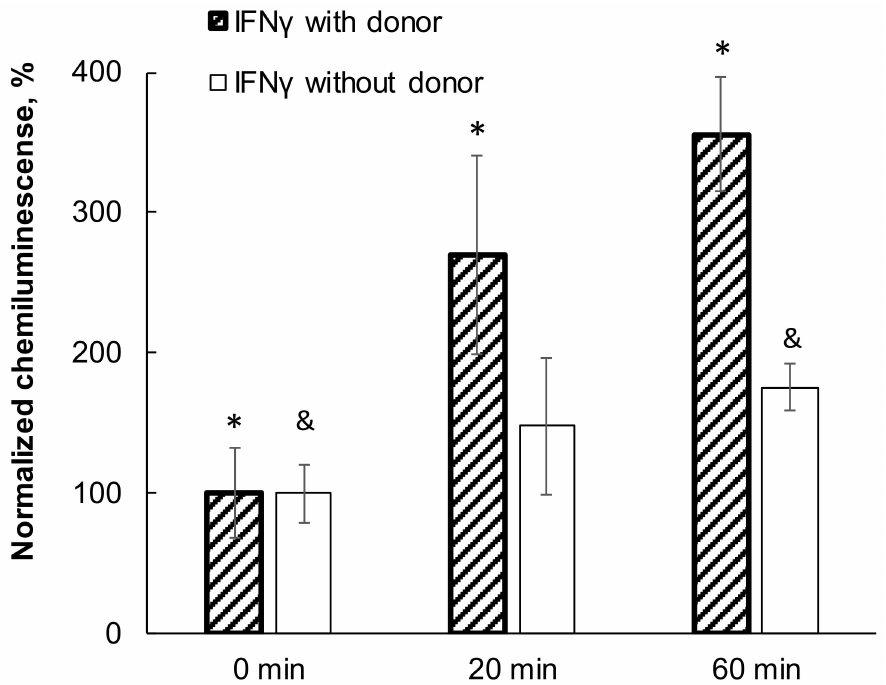
Figure 4. Maximum chemiluminescence intensity of a suspension of neutrophils after the addition of an IFN γ solution jointly or separately incubated with samples of HD Abs to IFN γ . The samples contained: suspension of neutrophils—2.5 × 10 5 cells; an IFN γ solution (10 ng/mL) incubated for 0, 20, and 60 min in the presence of HD Abs to IFN γ (hatchet bar) or in the absence of HD Abs to IFN γ (white bar), which constituted 80% of the total sample volume; fMLF (2 µ M); luminol (0.35 mM). Measurements were performed at 37 ◦ C and pH 7.4; * p < 0.05 (in comparison with “0 min” for samples incubated with donor), & p < 0.05 (in comparison with “0 min” for samples incubated without